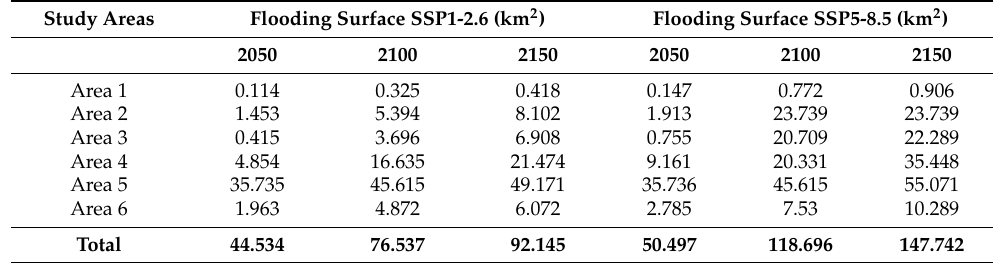
Table 4. Flooding surfaces were assessed for the studied areas under different sea-level projections. Study